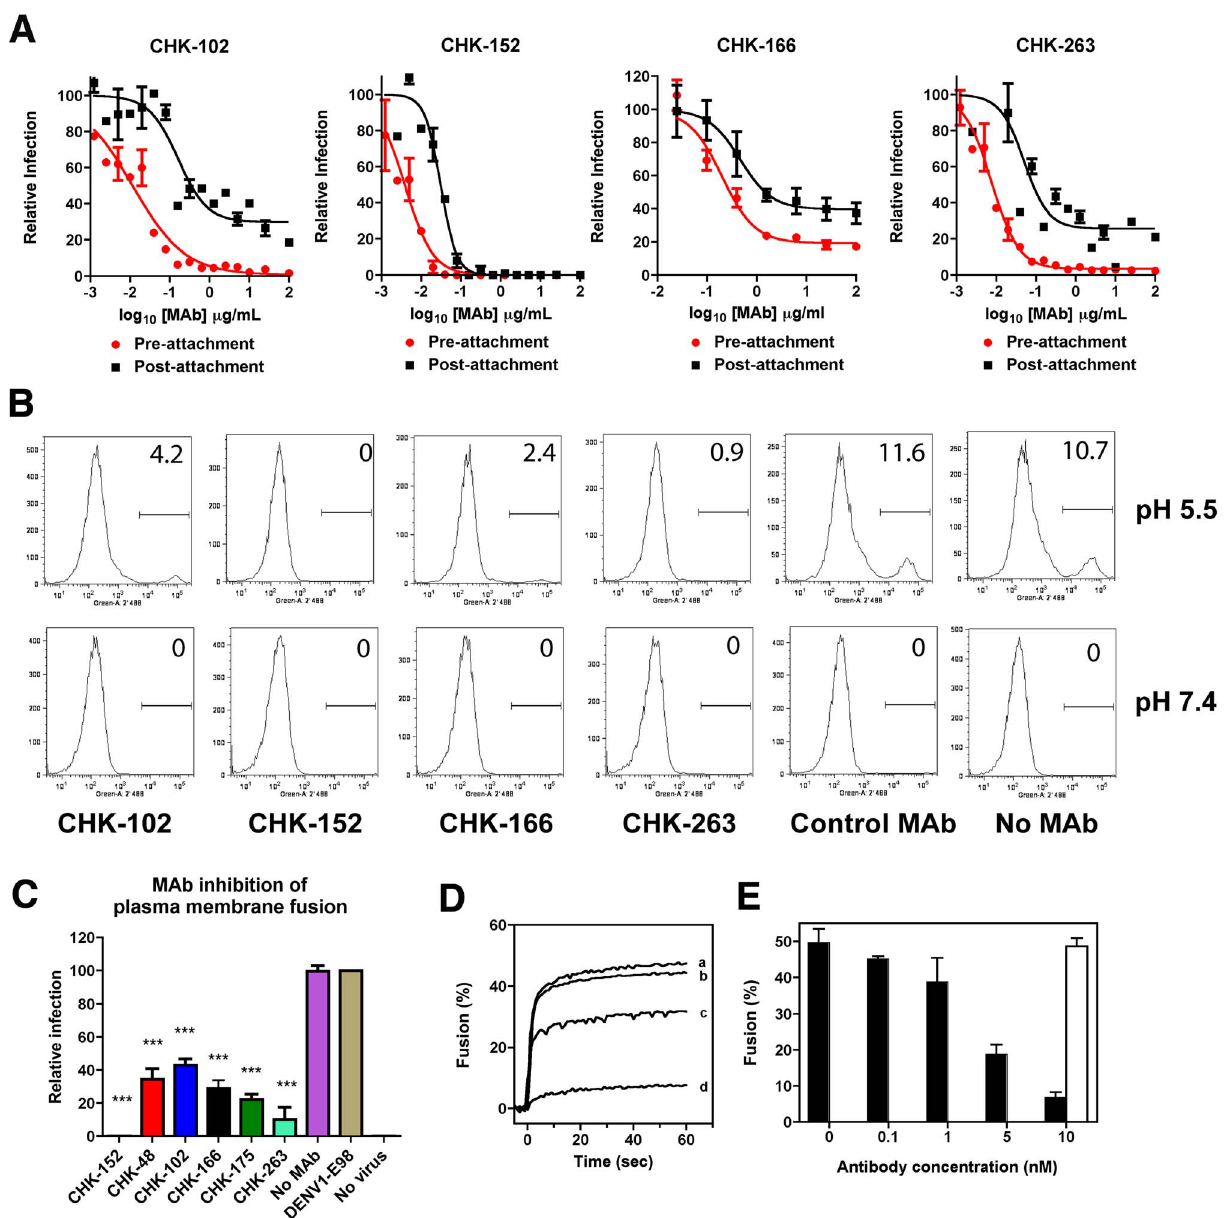
Figure 3. Mechanism of neutralization by CHIKV MAbs. A . Pre- and post-attachment inhibition assays. Vero cells were pre-chilled to 4 u C and 100 FFU of CHIKV-LR was added to each well for one hour. After extensive washing at 4 u C, the indicated MAbs were added for one hour at 4 u C, and then the FRNT protocol was completed ( black lines , Post ). In comparison, a standard pre-incubation FRNT with all steps performed at 4 u C is shown for reference. Virus and MAb are incubated together for one hour at 4 u C, prior to addition to cells ( red lines, Pre ). Data shown are representative of three experiments performed in duplicate with error bars representing standard deviation. B–C . FFWO assay. CHIKV was incubated with Vero cells at 4 u C to allow virus attachment. Free virus was removed after washing and 50 m g/ml of the indicated MAbs (including DENV1-E98, a negative control MAb) were added at 4 u C. Viral fusion at the plasma membrane was induced after a brief exposure to a low pH buffer. After pH normalization, cells were cultured for 14 hours in the presence of NH 4 Cl to inhibit infection through the endosomal pathway. Cells were analyzed for infection by staining with an anti-E2 MAb. Representative histograms are shown ( B ) and the data was pooled from four independent experiments for statistical analysis ( C ). For simplicity of display, not all of the MAbs included in the summary graph are shown by flow cytometry analysis. Asterisks indicate values that are statistically different ( P , 0.05) from the control MAb. Error bars represent standard deviations. Note low pH-triggered viral fusion at the plasma membrane is an inefficient process with only 10 to 20% of cells becoming infected even when a high MOI was used. D–E . Viral membrane fusion with liposomes. Fusion of pyrene-labeled CHIKV was measured at pH 4.7 (37 u C) using liposomes consisting of phosphatidylcholine, phosphatidyleth- anolamine, sphingomyelin, and cholesterol in a molar ratio of (1/1/1/1.5), as described in the Methods. ( D ) Curve a, no MAb; curve b, 0.1 nM CHK-152; curve c, 1 nM CHK-152; curve d, 10 nM CHK-152. ( E ) Extent of fusion (average value between 50 to 60 seconds post acidification) at increasing concentrations of MAb. Black bars, CHK-152; white bar, isotype control (MAb 0031, only included at 10 nM concentration). All fusion measurements were performed at least three independent times.